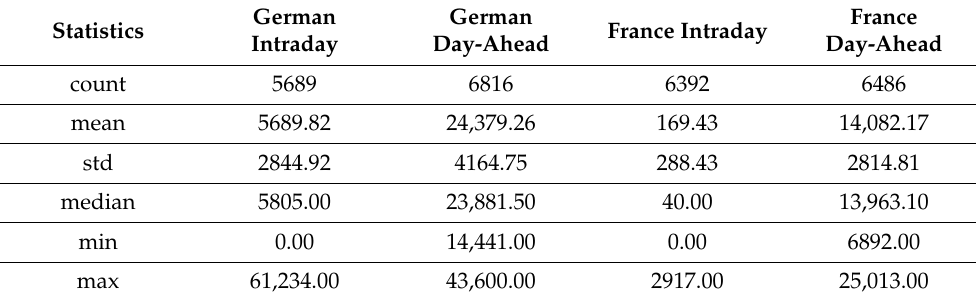
Table 3. General Statistics across German and French Volumes in